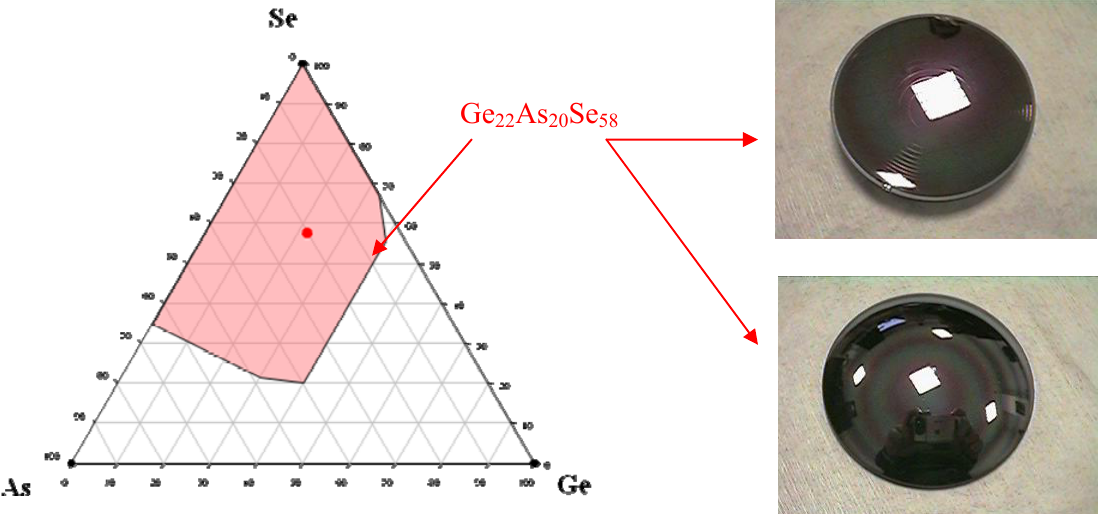
sophisticated diffractive (above on the right) and aspheric (below on the right)